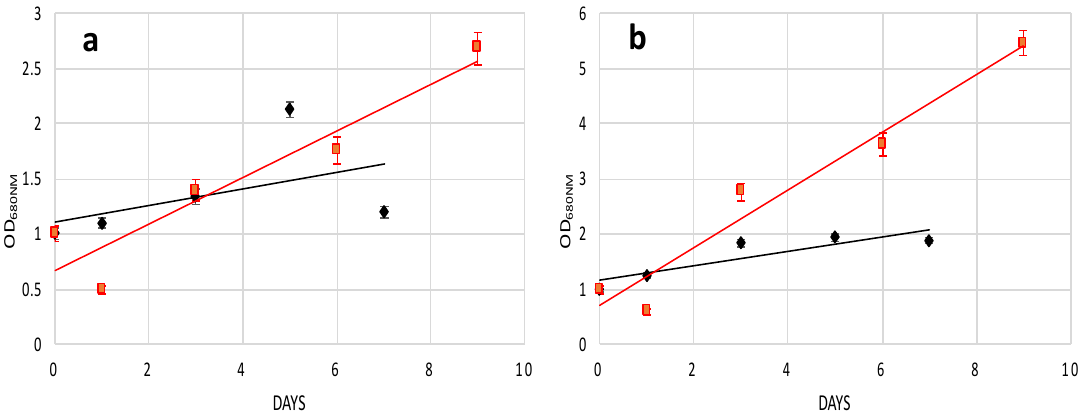
Figure 6. Recovery trend lines of H. pluvialis protoplast cells after transformation with magnetic nanoparticles. ( a ) H. pluvialis protoplast pretreated with cellulase digestion (8 h) in media supplemented with 1% glucose. ( b ) H. pluvialis protoplast pretreated with glass beads in media supplemented with 1% glucose. ( a , b ) Overlapping of recovery trend lines of H. pluvialis protoplast pre-treated with both methods, non-electroporated cells (red) and electroporated cells (black).